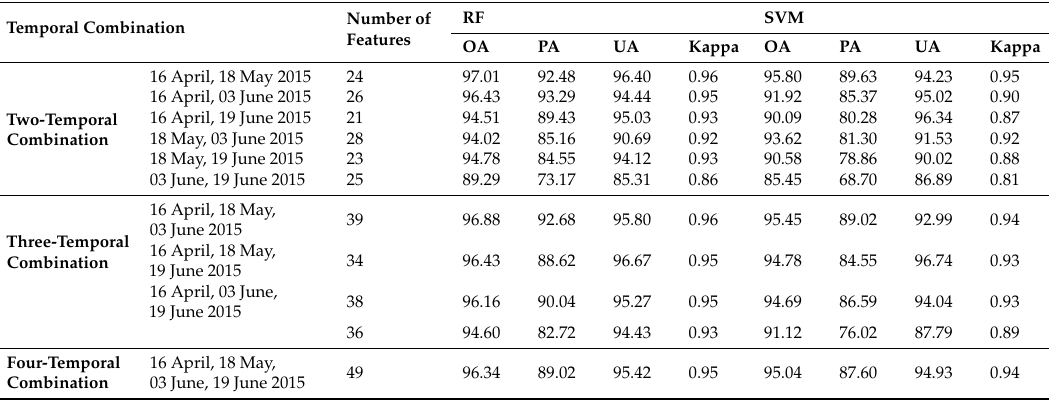
Table 7. The mapping accuracies of PMF in Jizhou using combined multi-temporal features.